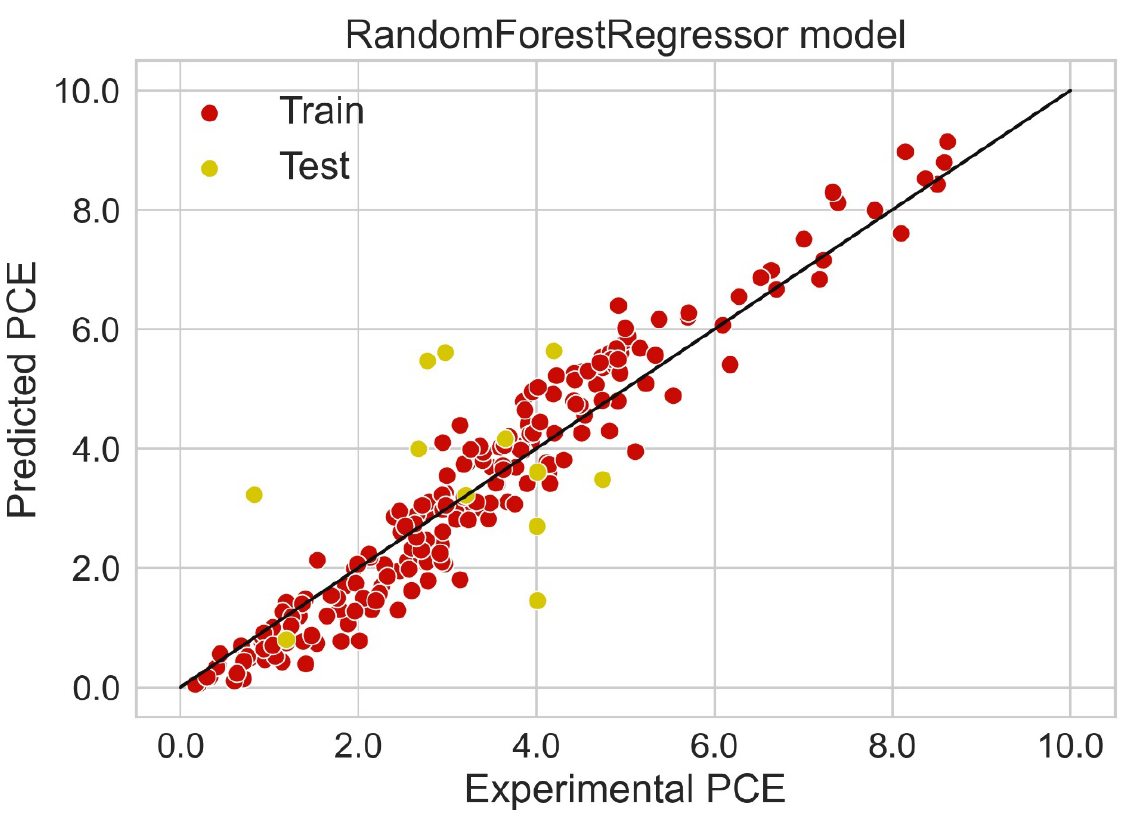
Figure 9. Scatter plot comparing experimental PCE and predicted PCE (random forest model).